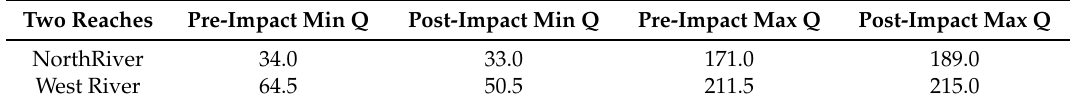
Table 3. The median of Julian date of the extreme streamflow.